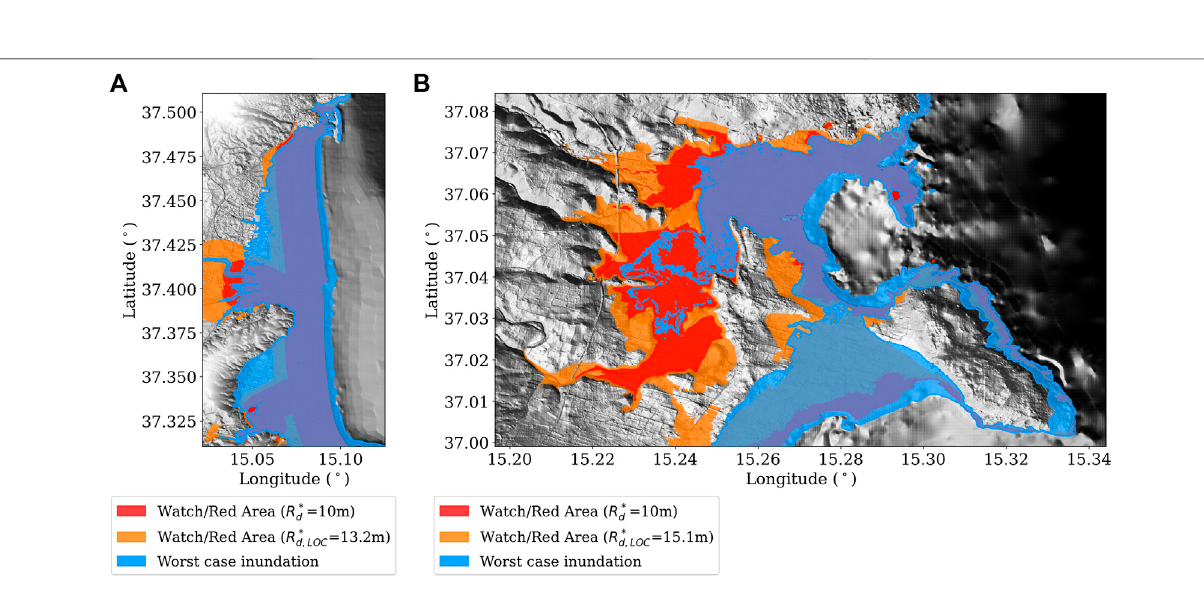
Frontiers in Earth Science |